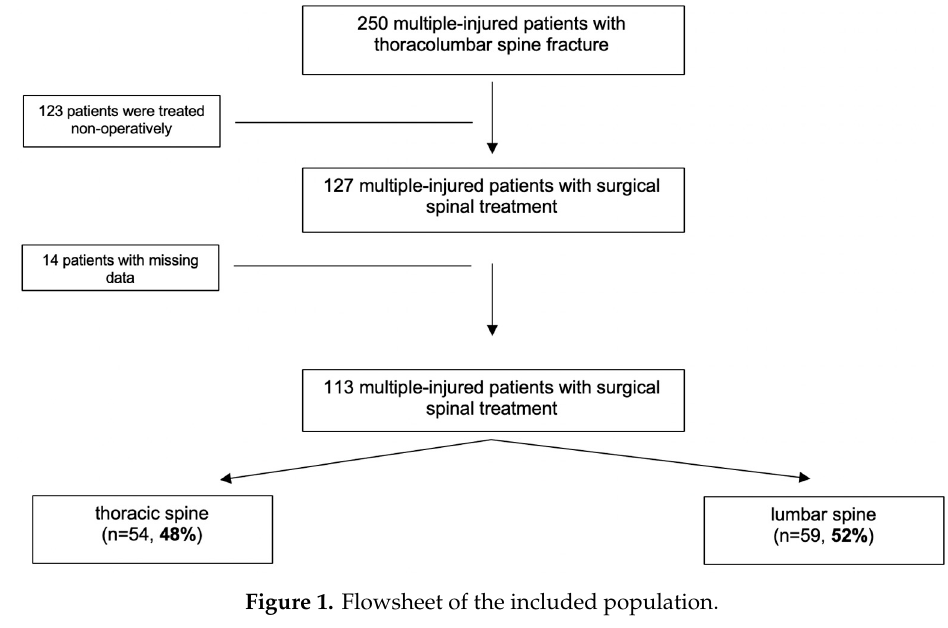
Figure 1. Flowsheet of the included population.